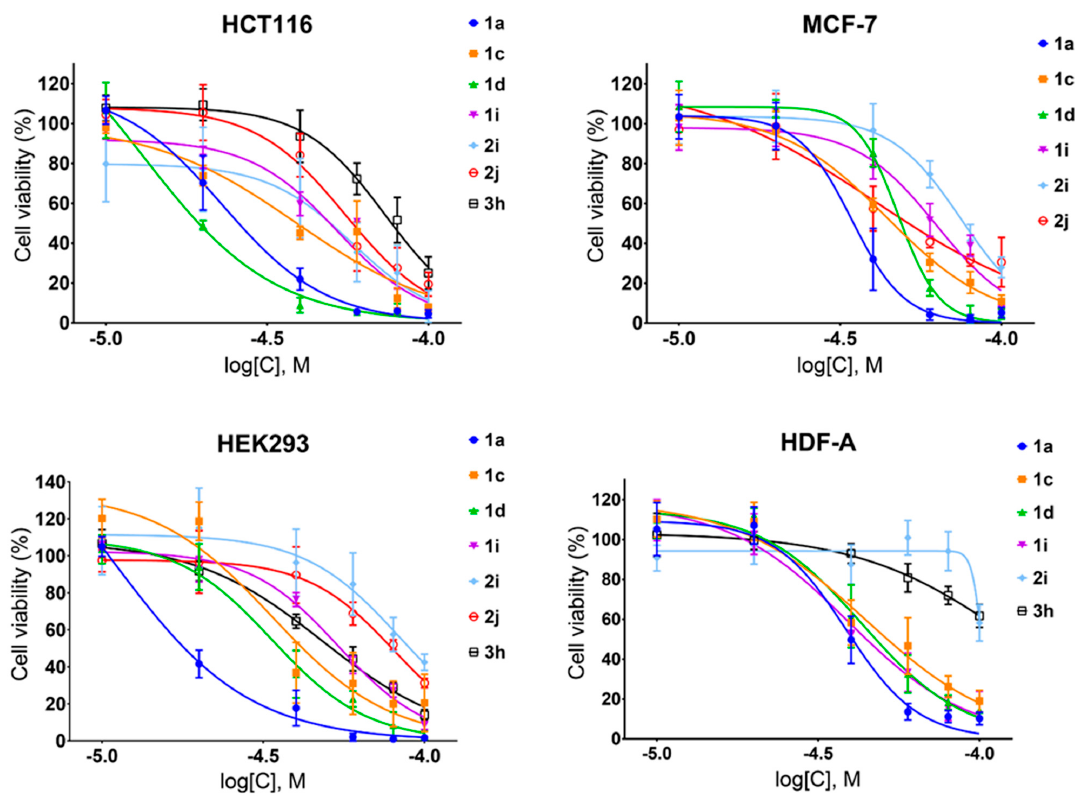
Figure 3. Activity of compounds 1a , 1c , 1d , 1i , 2i , 2j , and 3h , in cancer cell lines (HCT116 and MCF-7) and normal cell lines (HEK293 and HDF-A) as determined with an MTT assay after 48 h of treatment. Experiments were performed in triplicate (N = 3). Data are presented as the mean ± SD.